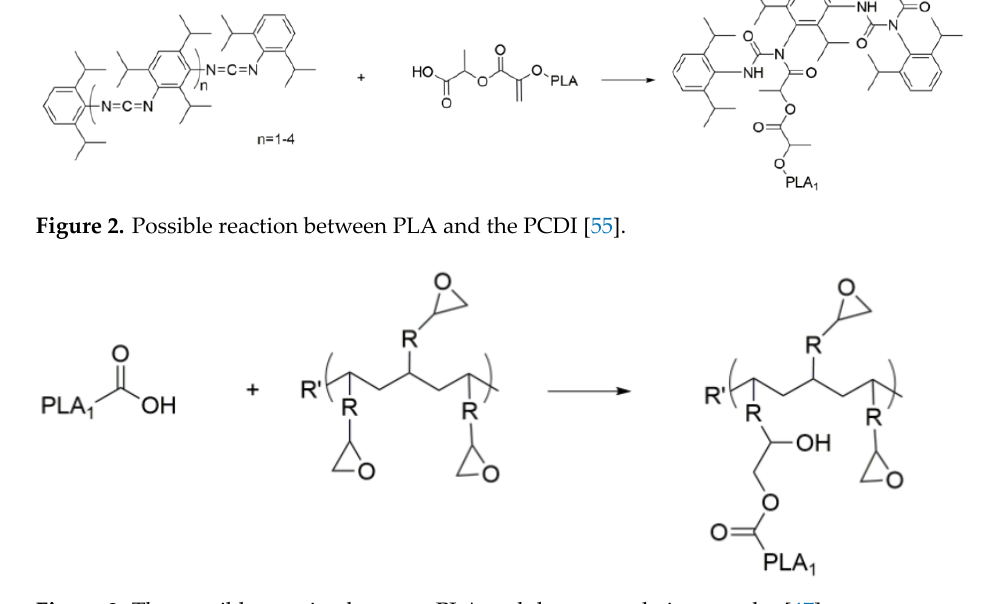
Figure 3. The possible reaction between PLA and the epoxy chain extender [47].